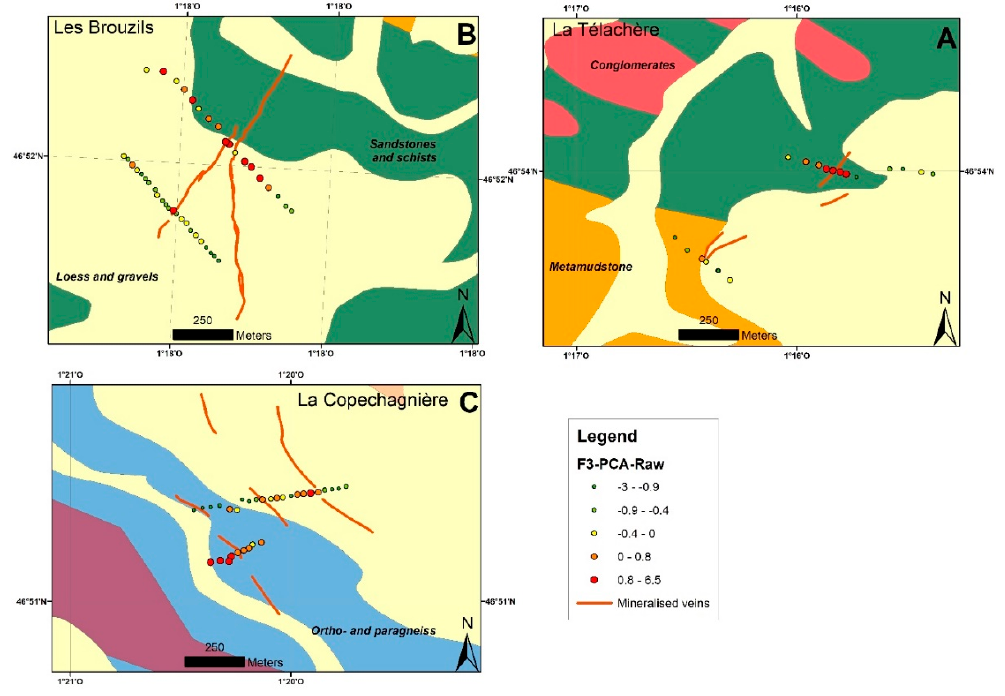
Figure 18. PCA F3 map of B horizon samples (pXRF measurements in mg/kg). ( A ): La Télachère; ( B ): Les Brouzils; ( C ): La Copechagnière.